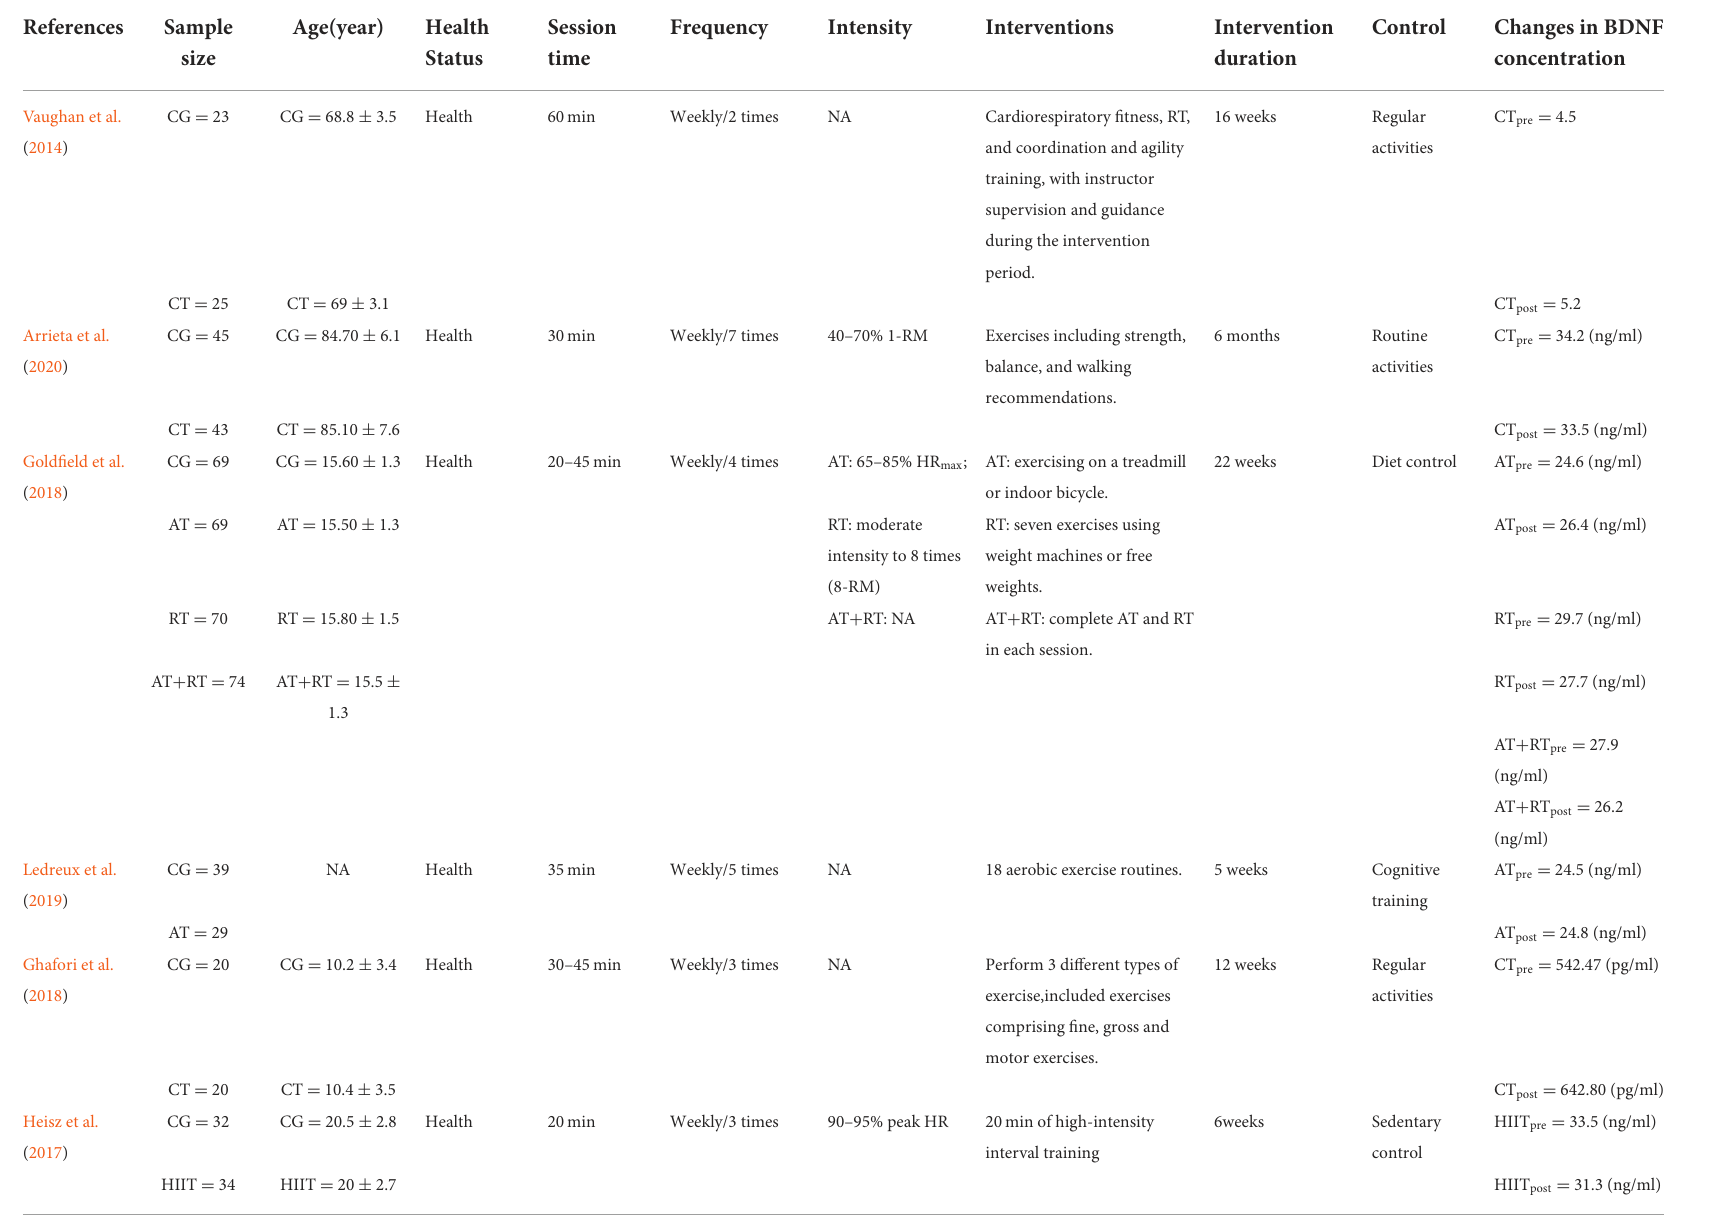
TABLE 3 Characteristics of the included